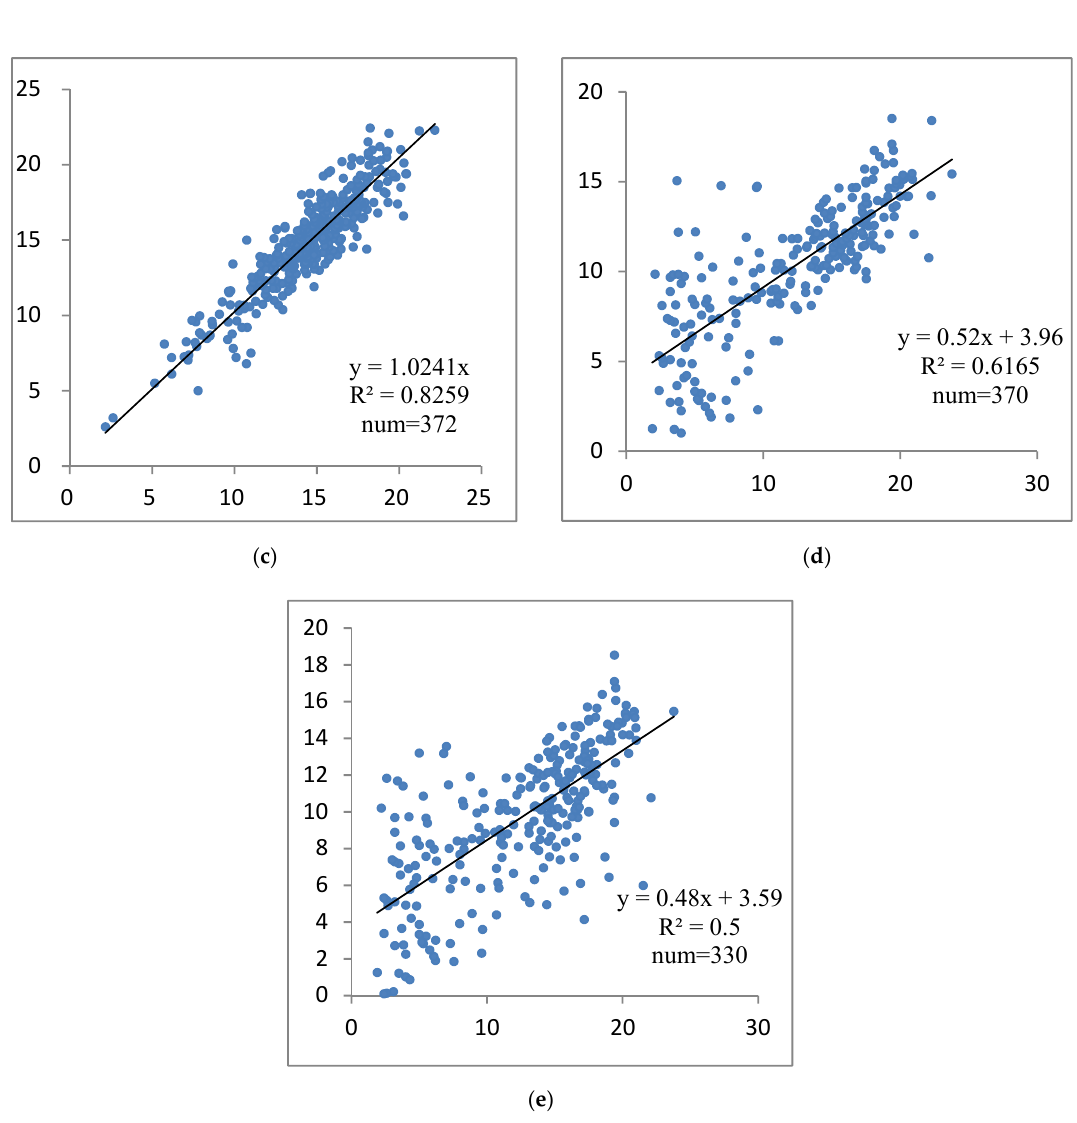
Figure 7. The scatter plot of the measured and extracted tree heights by ( a ) Max_H, ( b ) Max_CHM, ( c ) watershed, ( d ) cosine-template-matching, and ( e ) cone-template-matching algorithms ( X -axis is measured tree height; Y -axis is extracted tree height).